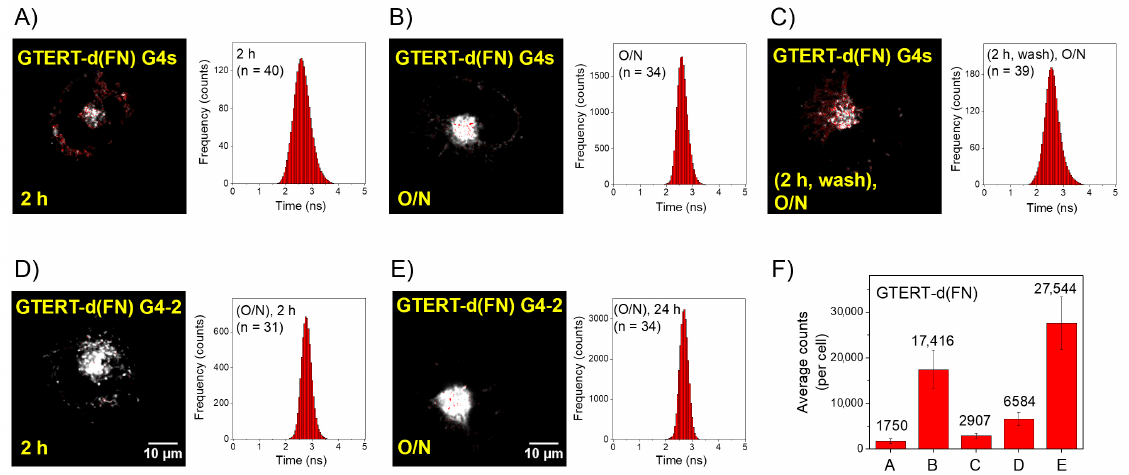
Figure 2. Time-gated FLIM images of exogenous GTERT-d(FN) G4s in CL1-0 live cells. Time-gated FLIM images of 5 µ M o -BMVC mixed with 15 µ M GTERT-d(FN) G4s incubated with CL1-0 live cells for 2 h ( A ) and overnight (O/N) ( B ). The incubation of 5 µ M o -BMVC mixed with 15 µ M GTERT-d(FN) G4s with CL1-0 live cells for 2 h followed by washing twice with PBS and then cultivated in a new medium for O/N culture ( C ). The incubation of 5 µ M o -BMVC mixed with 15 µ M GTERT-d(FN) G4-2 with CL1-0 live cells for 2 h ( D ) and overnight (O/N) ( E ). Here a decay time ≥ 2.4 ns is characterized in white and a decay time < 2.4 ns is characterized in red. The histograms of the average photon counts per cell with a decay time ≥ 2.4 ns for each case ( F ).